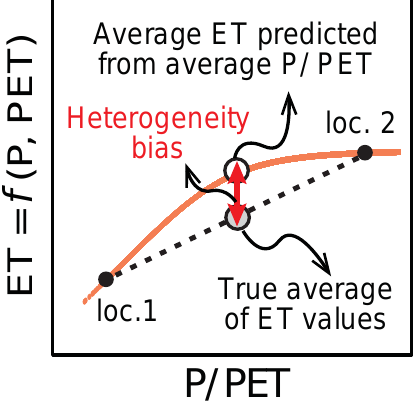
Figure 3. Illustration of heterogeneity bias in a Budyko curve (Eq. 5). The true average (gray circle) of the ET values of loca- tions 1 and 2 (black dots) is less than the average ET that would be estimated from their average P /PET (open circle). The size of the heterogeneity bias will be proportional to the curvature in the ET function and proportional to the variability in P and PET among the individual points (Eqs.